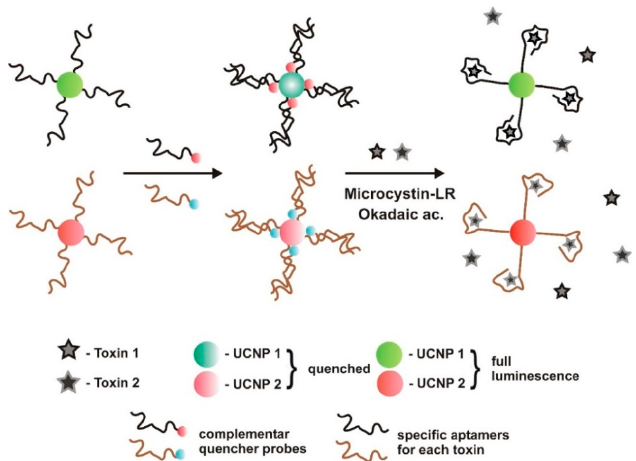
Figure 4. Dual fluorescent resonance energy transfer (FRET) aptasensor, developed by Wu et al. [59] to monitor microcystin-LR and okadaic acid, simultaneously. In the presence of these toxins, the aptamers prefer to bind to them and de-hybridize from the complementary DNA, preventing green and red luminescence quenching. UCNP—Upconversion